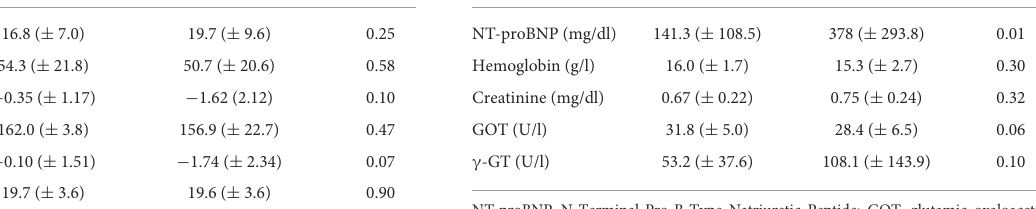
TABLE 3 Laboratory results represented as means with standard deviation in brackets and the p -value for the t -test between the two groups.